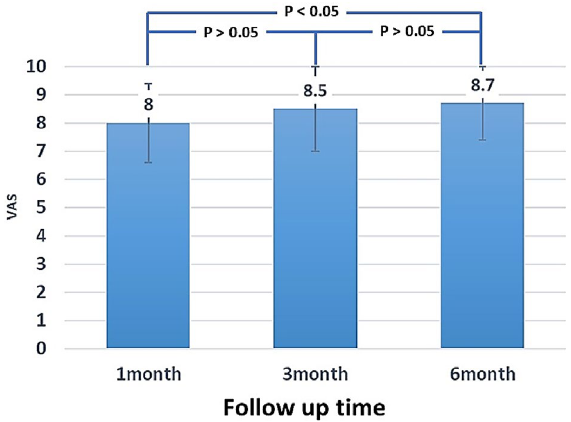
Figure 4. The visual analogue score of patients’ satisfaction with their voice change after surgery revealed a mean score of 8.0 ± 1.4 at 1 month, 8.5 ± 1.5 at 3 months, and 8.7 ± 1.3 at 6 months. A significantly different mean score between 1 and 6 months was observed (p <